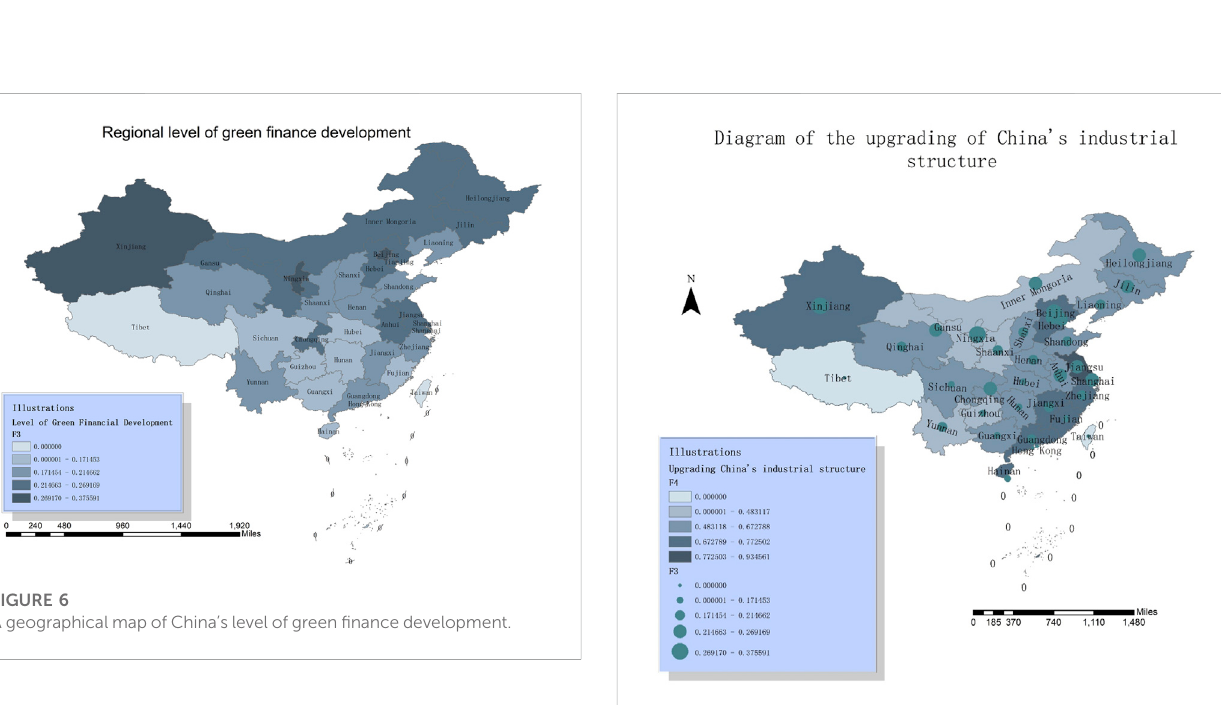
FIGURE 7 China ’ s industrial structure and the state of green fi nance